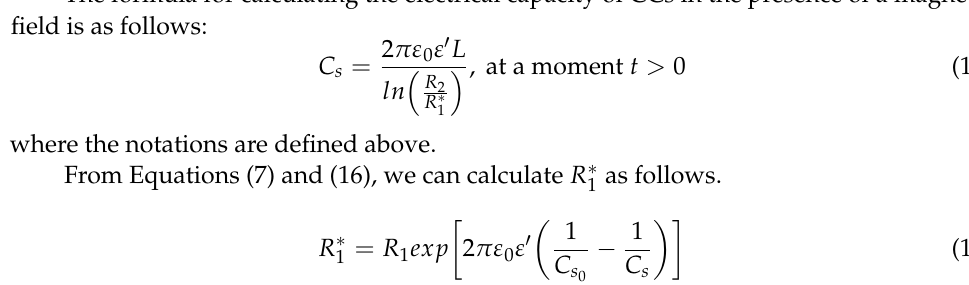
Figure 13. Solid microparticles in the polyurethane sponge matrix placed between the CC armatures (model): ( a ) in the moment of applying the magnetic field ( t = 0 ) ; ( b ) a while after the magnetic field was applied ( t > 0 ) ; 1 and 2—metallic armatures; 3—polyurethane sponge; CIP—carbonyl iron microparticles; → m —magnetic dipole; δ —the vector of magnetic field intensity gradient; Oz— coordinate axis; R 1 —internal cylinder radius; R 2 —external cylinder radius; R ∗ —the apparent radius. 1